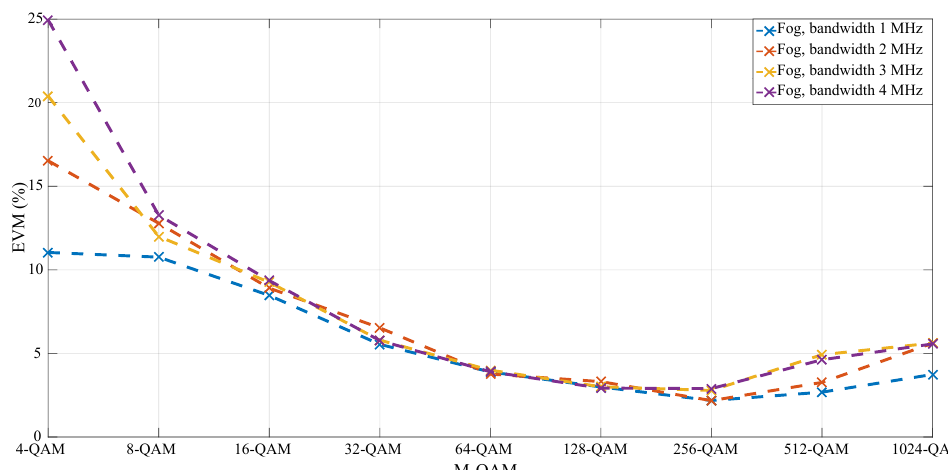
Figure 38. EVM/distance relationship for Octavia tail-light with different M-QAM and bandwidths —scenario